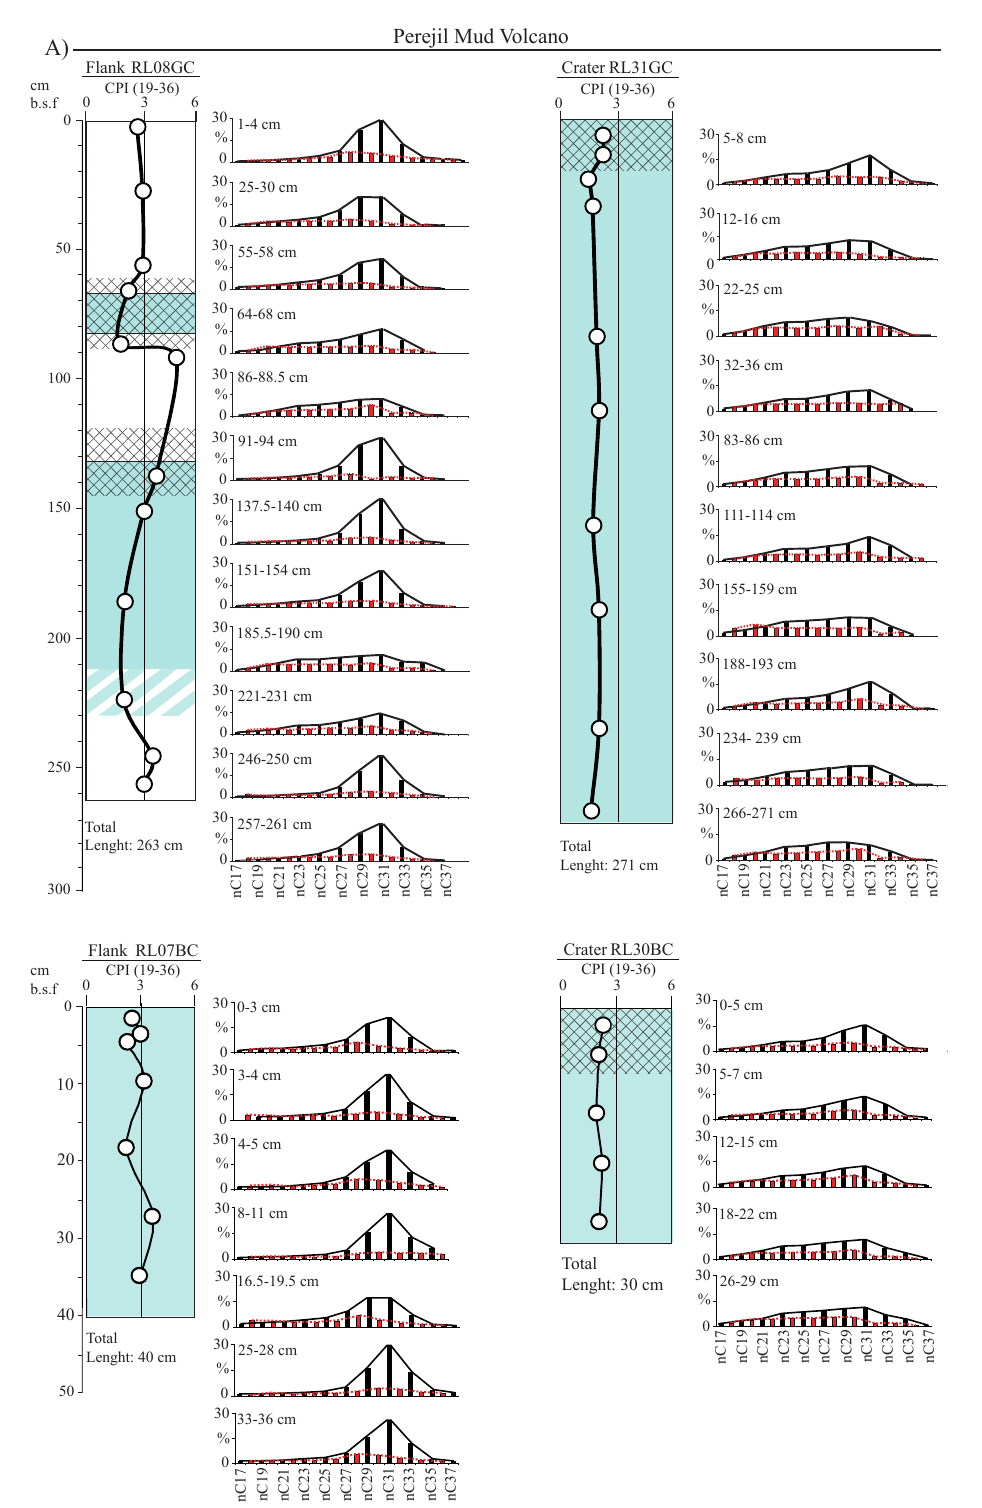
Figure 3. Distribution of n alkanes and carbon preference index (CPI) profiles along the sedimentary sections for (A) Perejil MV flank and crater and (B) Kalinin and Schneider’s Heart MVs. Striped area corresponds to hemipelagic sediments with lipid characteristics of mud breccia. Relative concentrations were calculated by normalization of peak areas obtained by gas